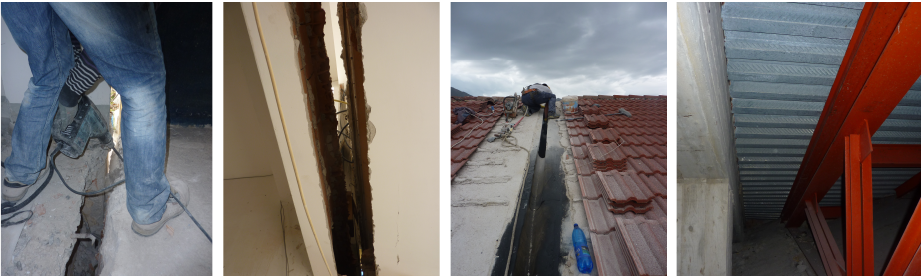
Figure 3. Details of the structural joints upgraded during the 2012 interventions (from left to right): increment of the distance between floor slabs; effective distance between floor slabs visible after the interventions; waterproof layer on the joint between two roof slabs; corrugated steel sheet between adjacent buildings A and C under the joint (photo courtesy of R.